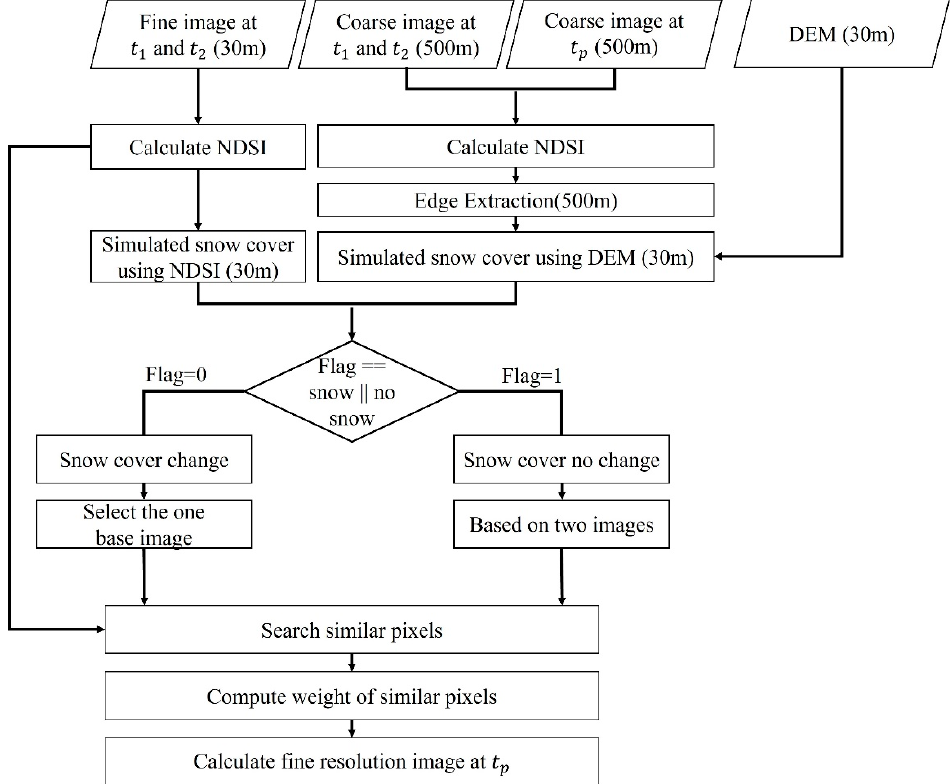
Figure 3. The flowchart of the iESTARFM algorithm.